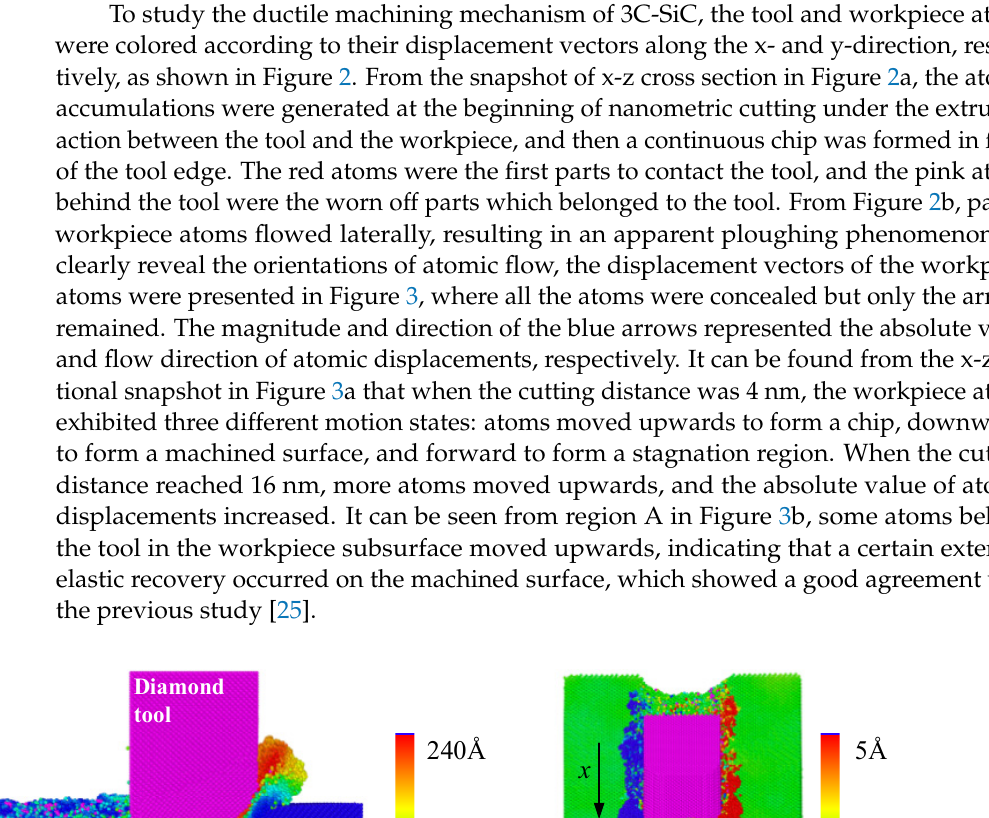
Materials 2022 , 15 , x FOR PEER REVIEW Figure 2. Variations of the atomic displacement vectors according to ( a ) x − and ( b ) y − direction.